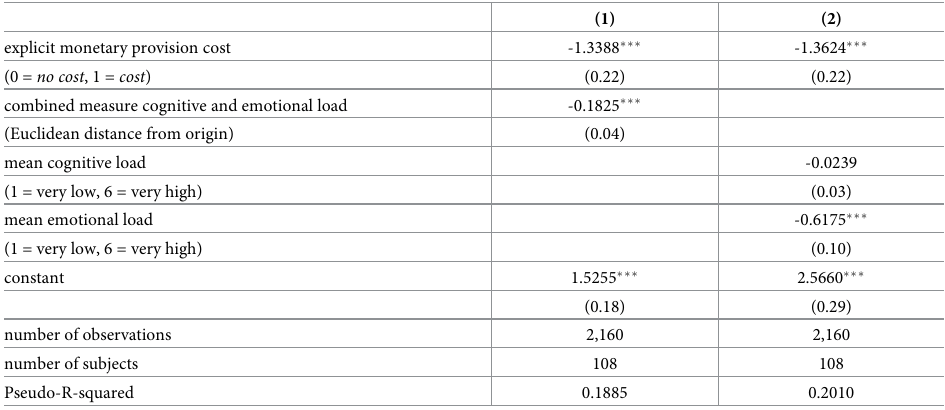
Table 5. Likelihood of item